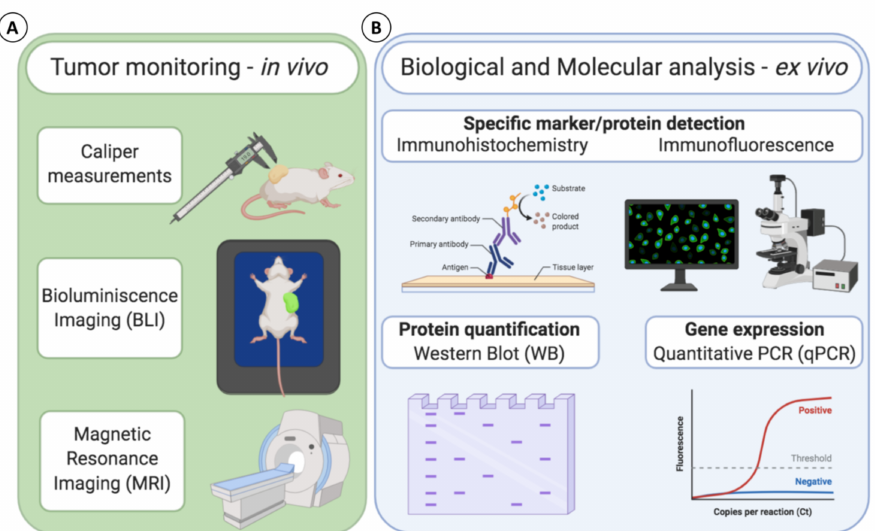
Figure 3. Possible methods available for tumor monitoring and biological molecular analysis to monitor and evaluate the effectiveness of PCL treatments in vivo. ( A ) Analysis applicable for tumor monitoring in vivo; ( B ) Biological and molecular analysis for ex vivo tumor